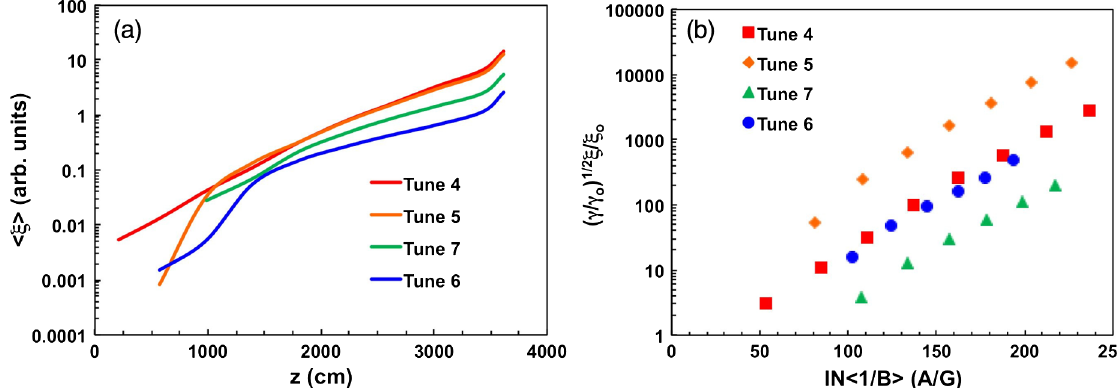
FIG. 8. (a) Reduction in the average BBU amplitude, h ξ i , over five shots at each z location due to the increased h B i with each successive tune and (b) comparison of BBU growth along the accelerator for each successive tune. Each tune indicates a constant transverse